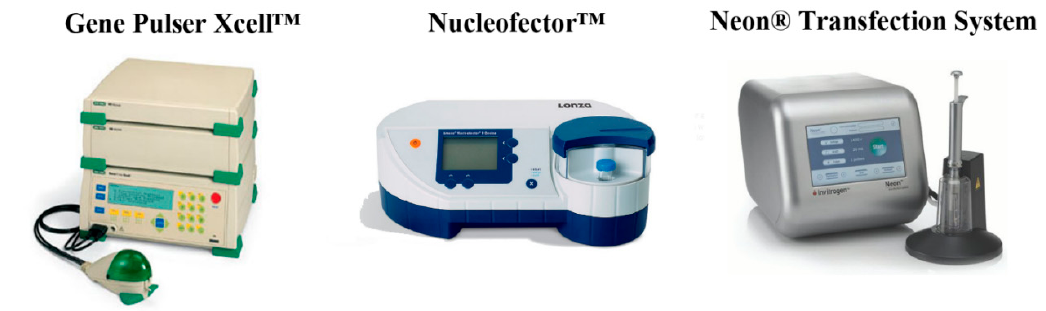
Figure 3. Commonly-used commercial bulk electroporation (BEP) system. From left to right: Gene Pulser Xcell™ from Bio-Rad, Nucleofector™ from Lonza, and Neon ® Transfection System from Thermo Fisher Scientific. Figures from Internet. copyright by the companies.